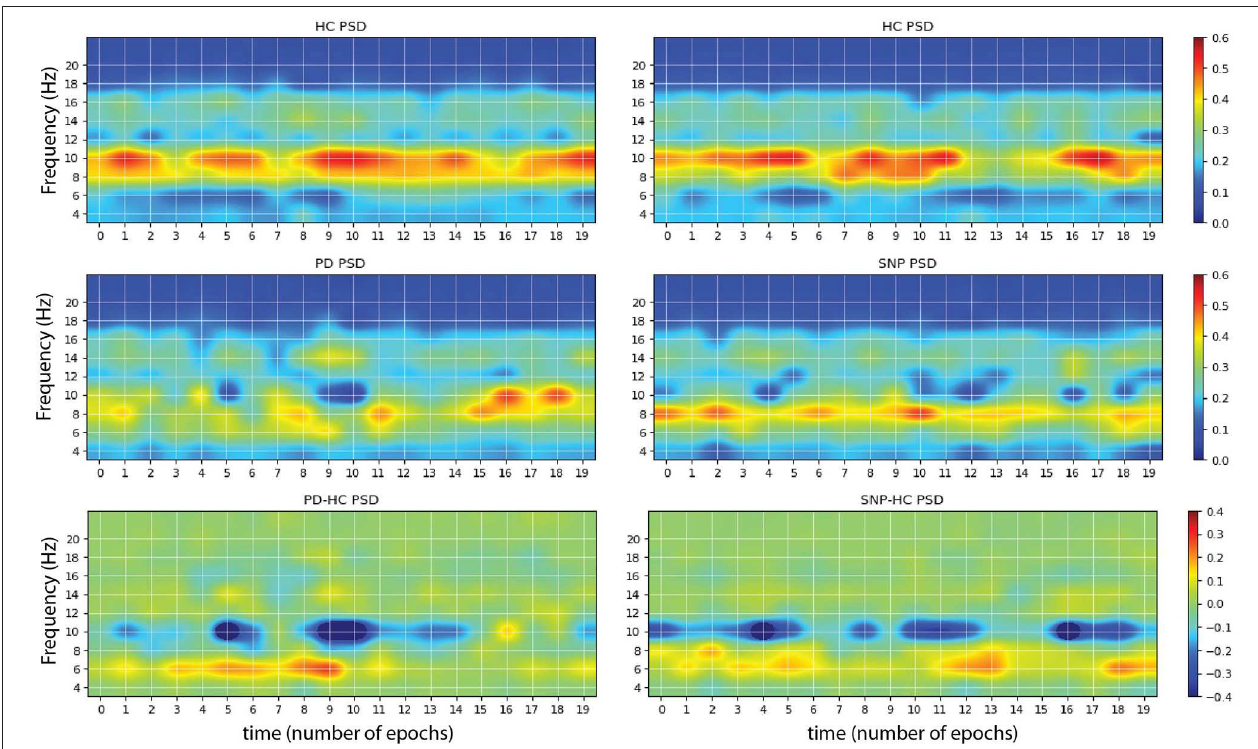
FIGURE 4 | Sample images produced by maximizing network outputs for a given class. (Left) From a network was trained using P4 electrode channel data on the problem of HC vs. PD. The main features are the presence of 10 Hz bursts in the image maximizing HC classification (Top) compared to more persistent 6 Hz power in the pathological spectrogram (Middle) . The difference of the two is displayed at the bottom. (Right) Network was trained using P4 electrode data on the problem of HC vs. PD+DLB (i.e., HC vs. RBDs that will develop an α -synucleinopathy or SNP). The main features are the presence of 10 Hz bursts in the HC class maximizing image (Top) compared to more persistent 6–8 Hz power bursting in the pathological spectrogram (Middle) .